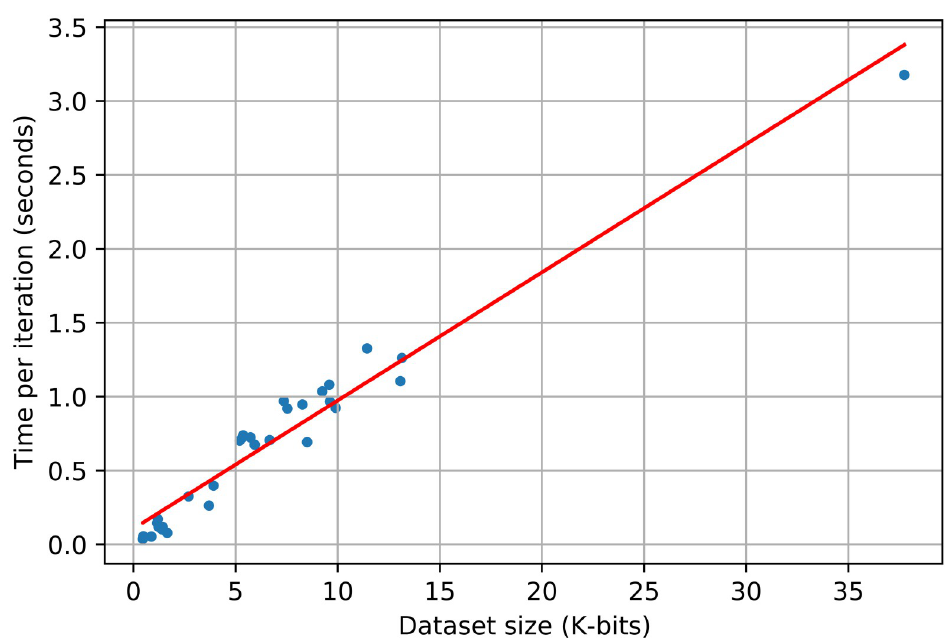
Fig 8. The per-iteration computational complexity of ToMExO with respect to the dataset size (number of tumors × number of events).